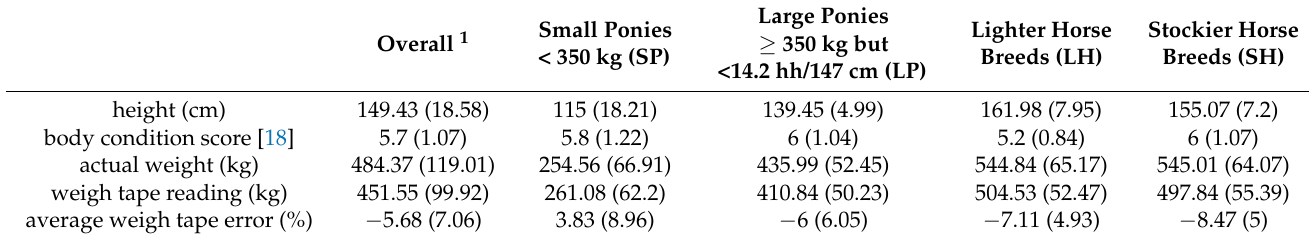
Table 1. Summary statistics for 1716 horse records overall and within each breed category